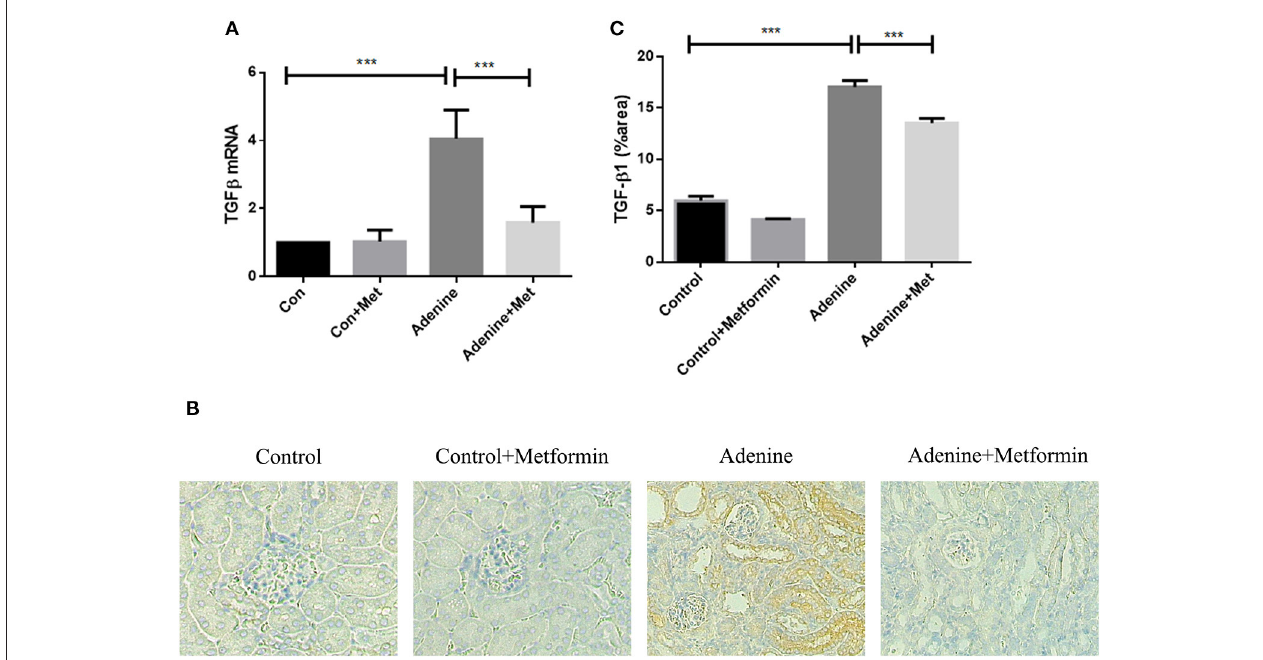
FIGURE 4 | Metformin suppresses the upregulation of TGF- β 1 expression in the mouse model of adenine-induced renal injury. qRT-PCR (A) and immunohistochemical staining (B,C) results demonstrated that the expression of TGF- β 1 was significantly increased in adenine-induced mice compared to the control mice, which was suppressed by metformin treatment. Data are expressed as mean ± SEM. *** P < 0.001, n = 8. Original magnification: ×